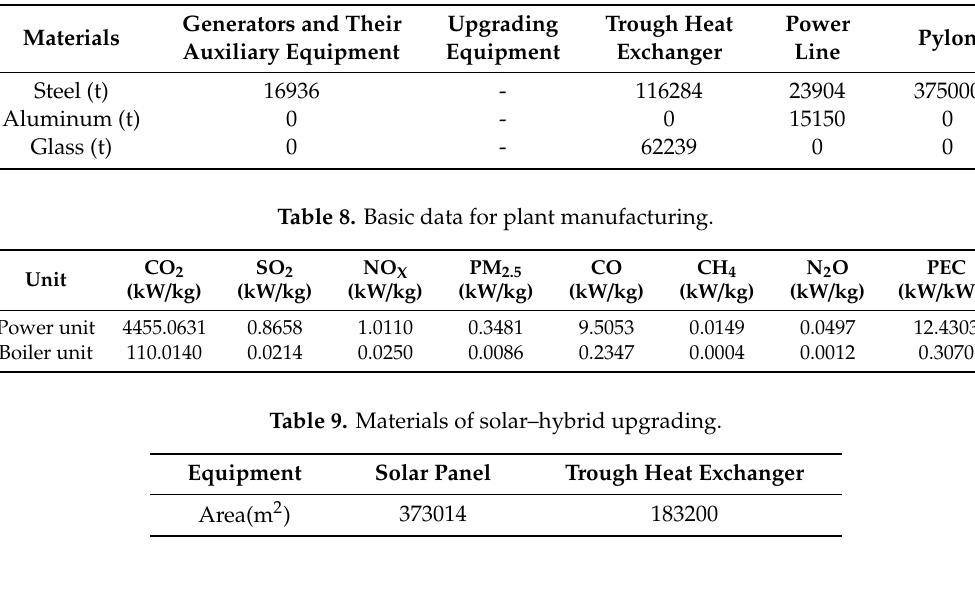
Table 7. Equipment material of direct coal-fired power plant.